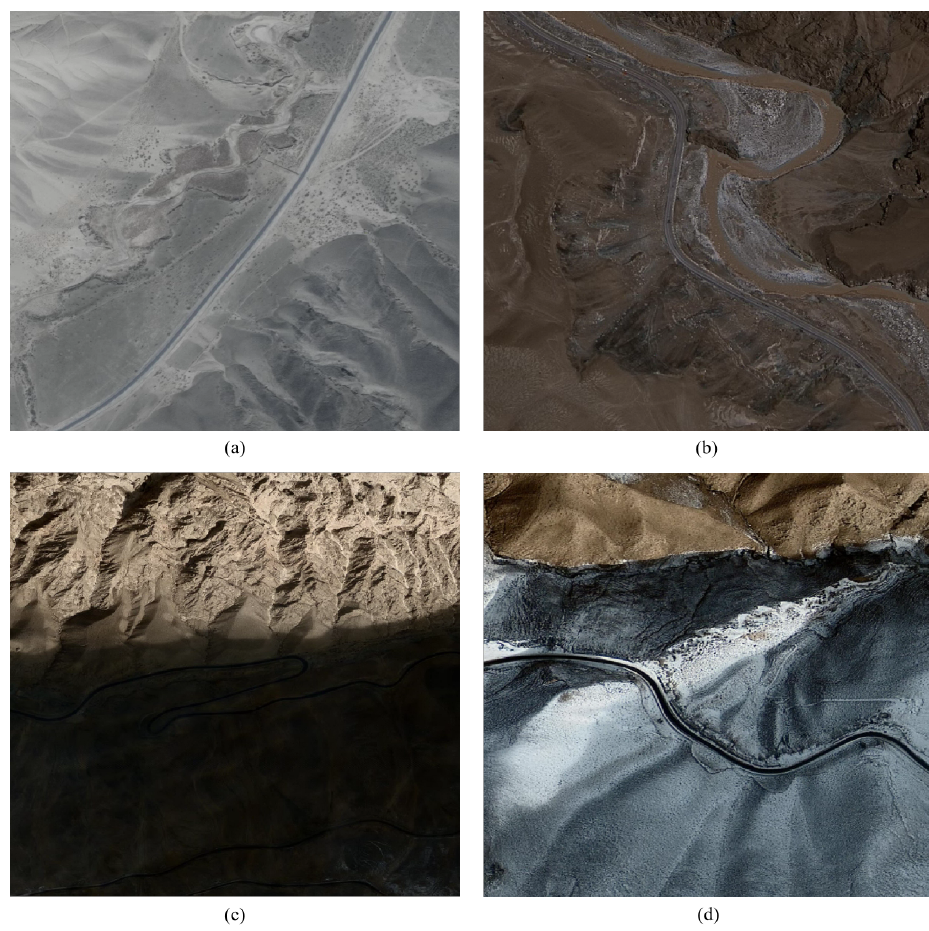
Figure 3. These pictures show the roads in a complex environment in RDCME. ( a ) is a road on a hill; ( b ) is a road near a river; ( c ) is a road in the shadow of a mountain; ( d ) is a road on a